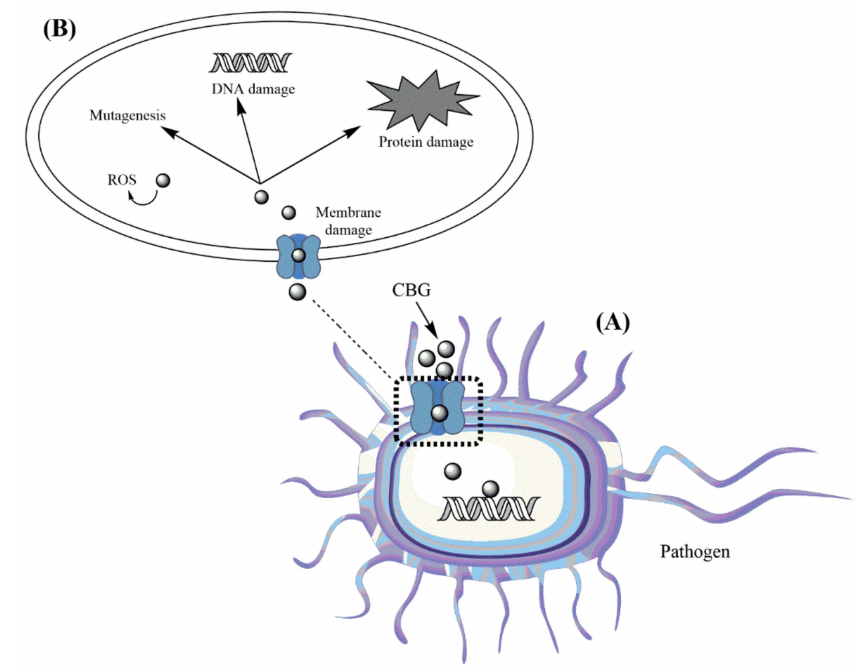
Figure 2. Schematic illustration of antibacterial mechanism of cannabinoid, with CBG (17) as an example. CBG (17) causes bacterial cytoplasmic membrane damage ( A ) that results in the destruction of protein and DNA and the production of reactive oxygen species (ROS) within the bacterial cell ( B ) (created with ChemDraw